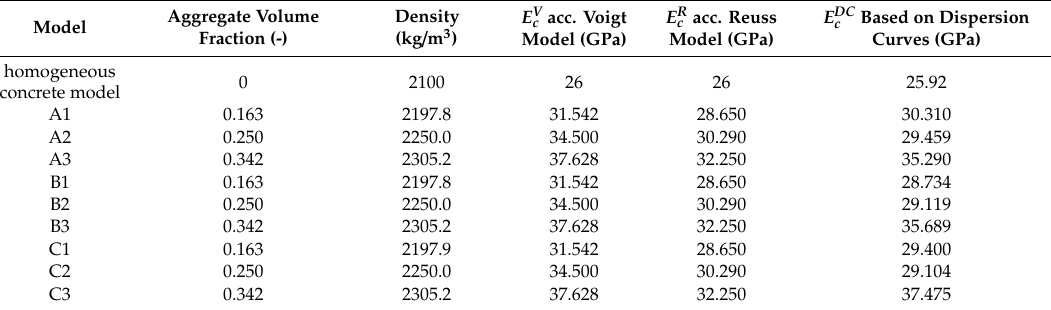
Table 3. Parameters of numerical